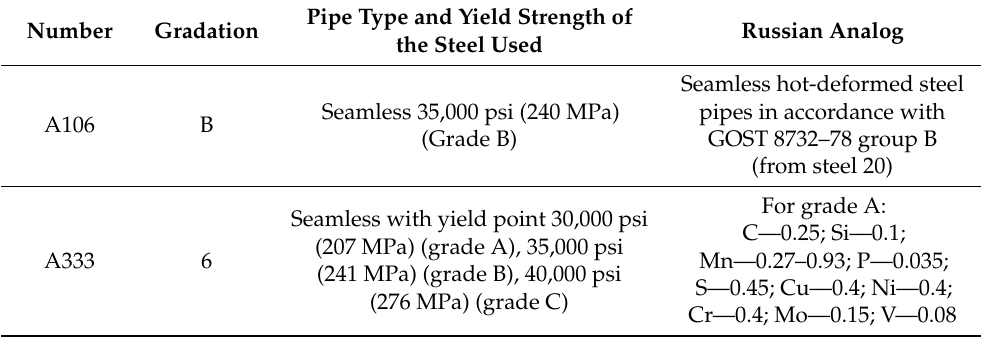
Table 13. Pipeline steel parts PL